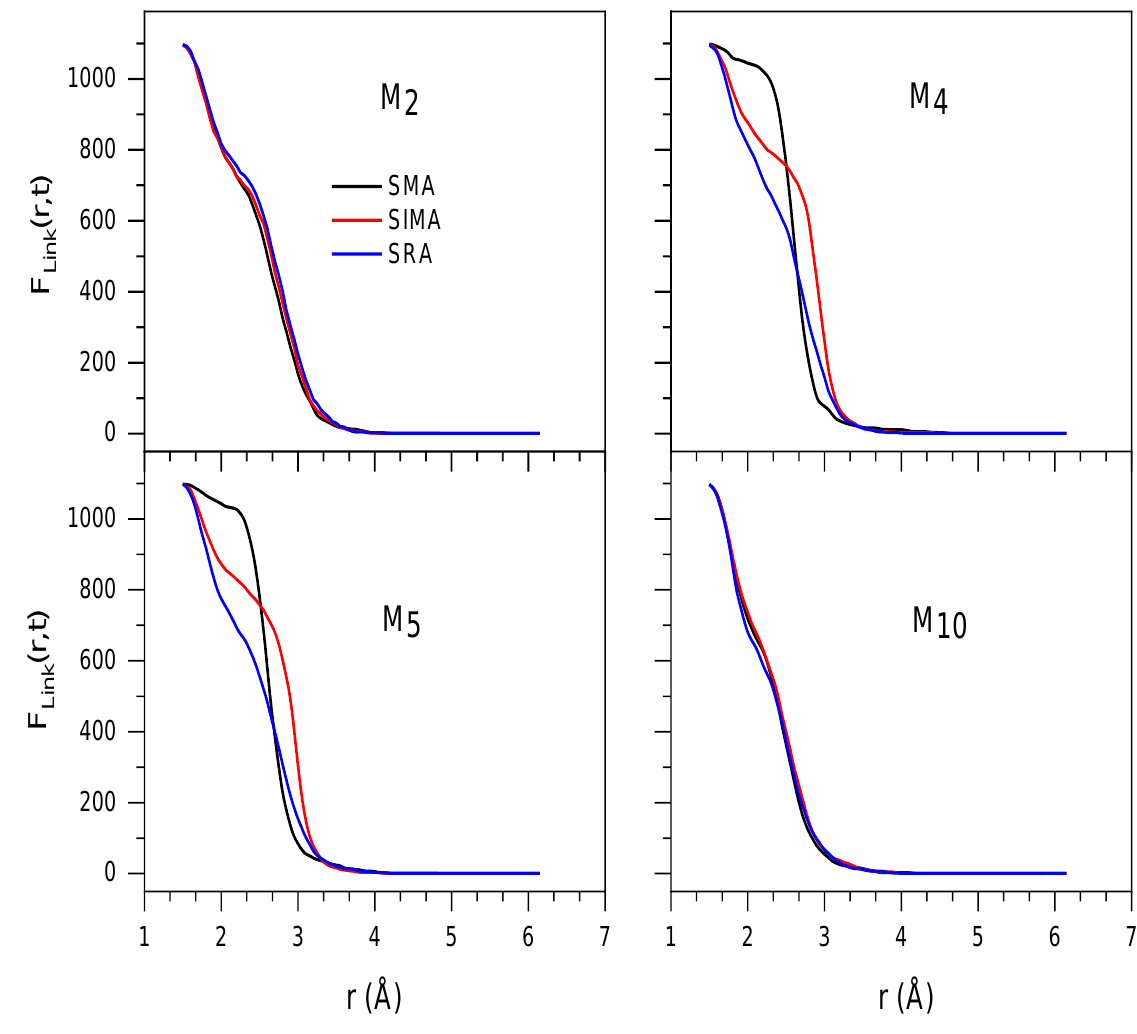
Figure 7. The link-cluster function at 5, 15, 20 and 80